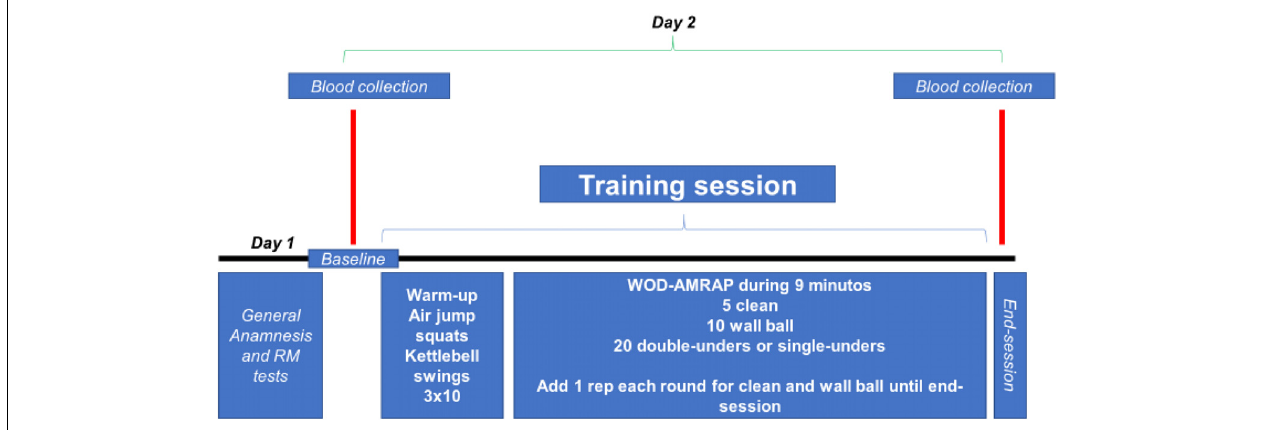
FIGURE 1 | Experimental design. WOD-AMRAP: workout of the day – as many reps as possible.